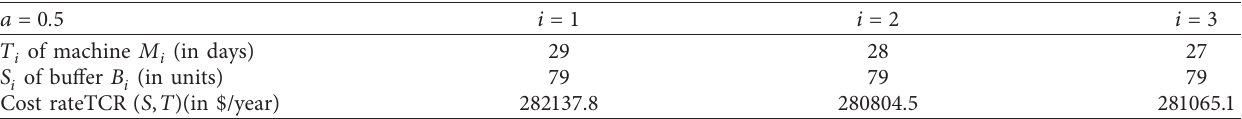
Table 5: The lowest cost rate with the optimal monitoring time of the machine of the intelligent series system and the optimal buffer stock for a � 0 .